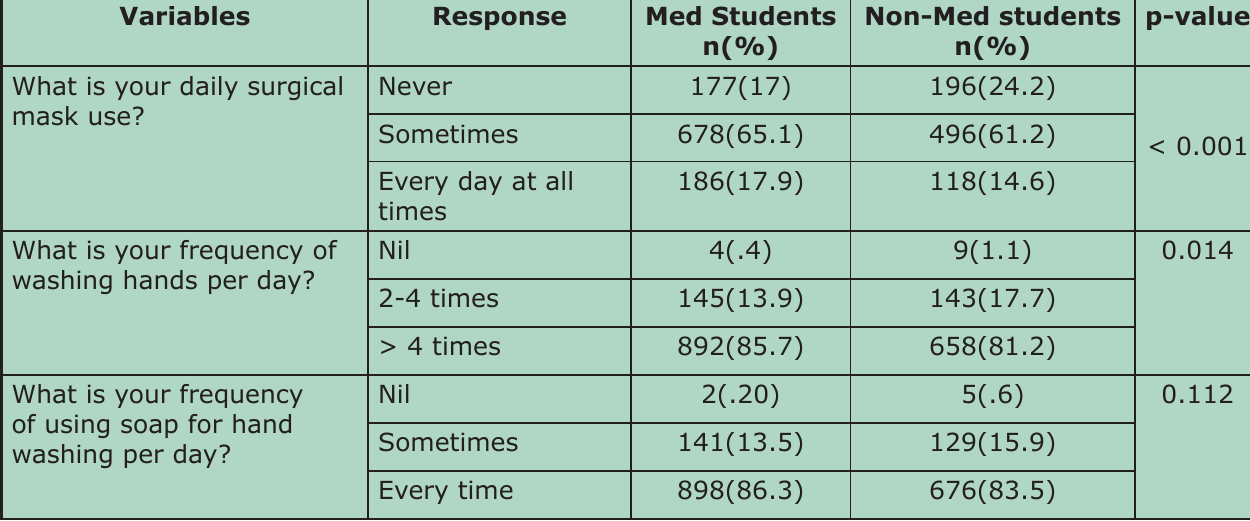
Table-IV: Comparison of COVID-19 practices between medical and non-medical students.